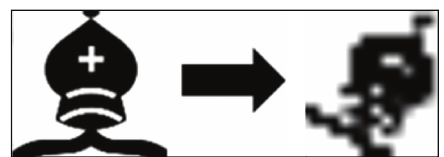
Figure 1: Embedding CAPTCHA by altering the appearance of a